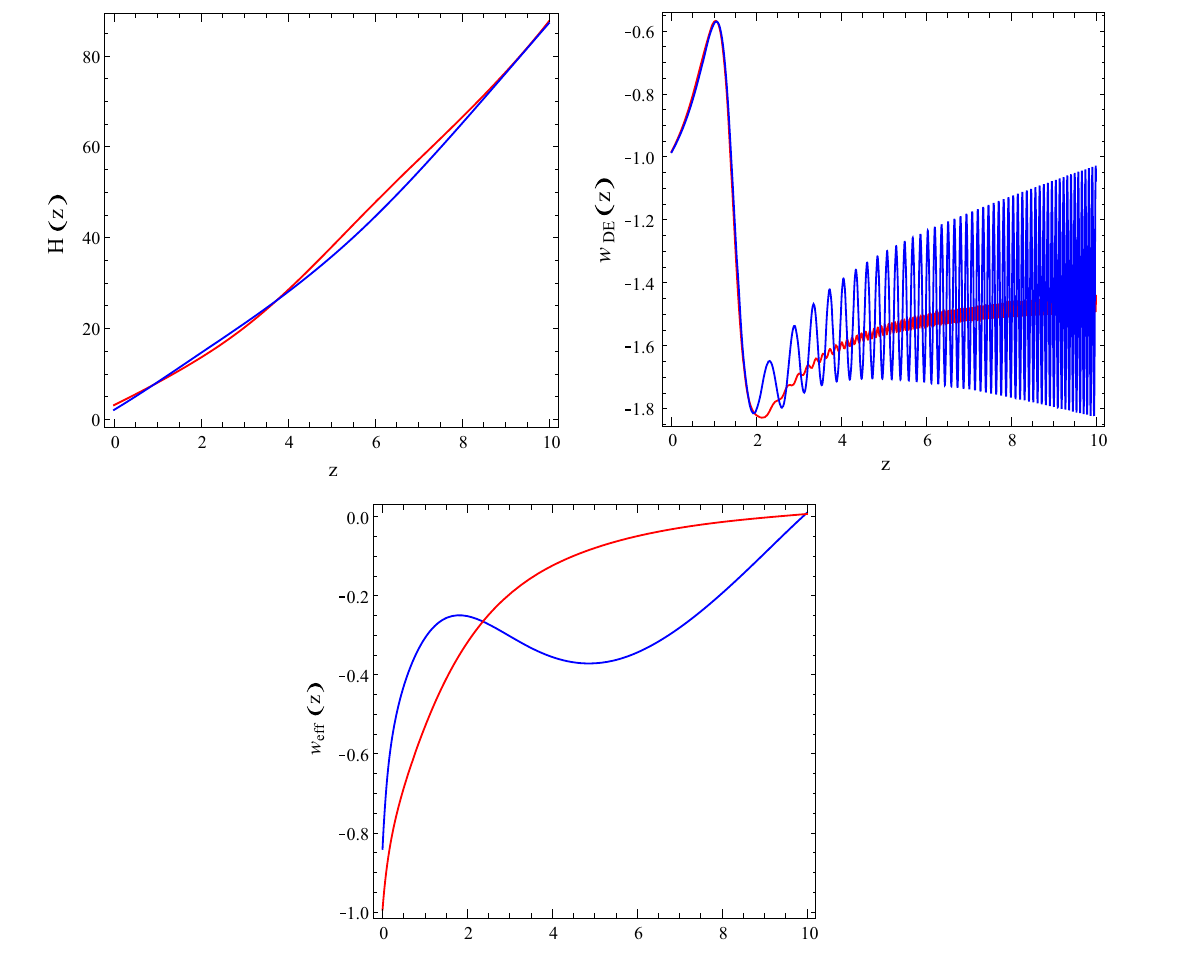
Fig. 2 Comparison of the Hubble parameter H ( z ) versus z , of the dark energy equation of state parameter w DE versus z and of the effective equation of state parameter w eff versus z . The red curves correspond to the mimetic f ( R , T ) in Universe filled with collisional matter, while